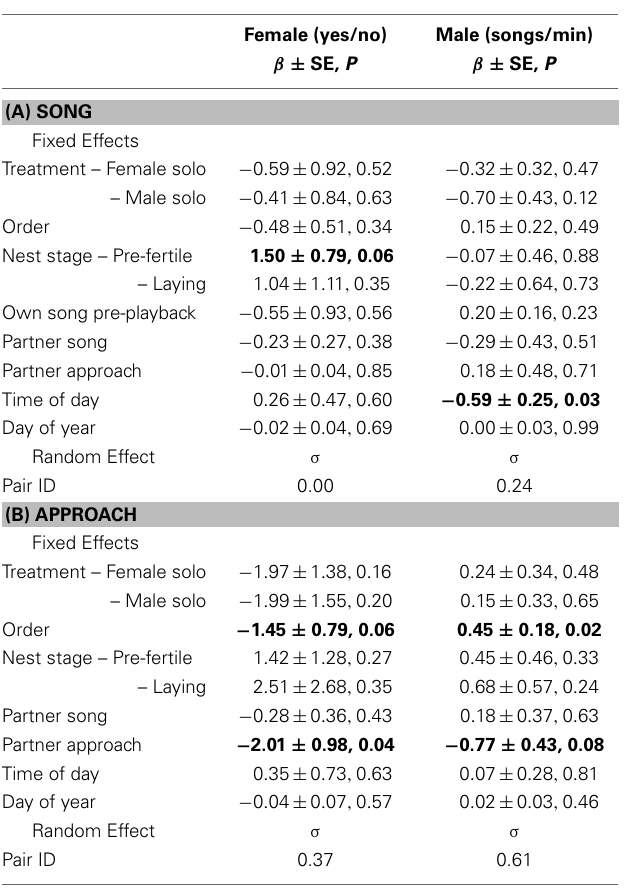
Table 4 | Effect of playback treatments on song and approach by females and males.